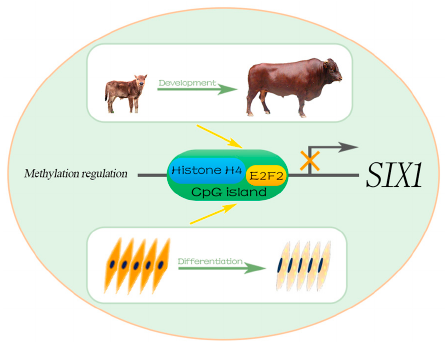
Figure 6. A hypothesized methylation regulatory mechanism of bovine SIX1 . The light green circle shows a specific methylation regulation progress of the bovine SIX1 promoter was regulated by histone H4 and E2F2 during the development. The green arrows indicate the progress of individual development and muscle cells differentiation of Qinchuan cattle. The yellow arrows indicate repression of SIX1 promoter activity by DNA methylation through histone H4 and E2F2 TF during